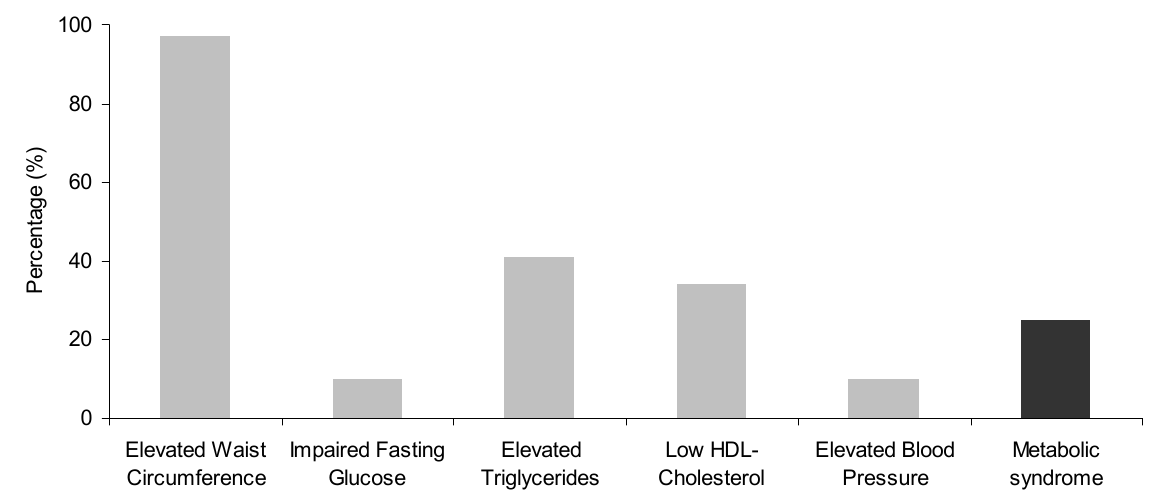
Figure 2. Prevalence of metabolic syndrome and its components at